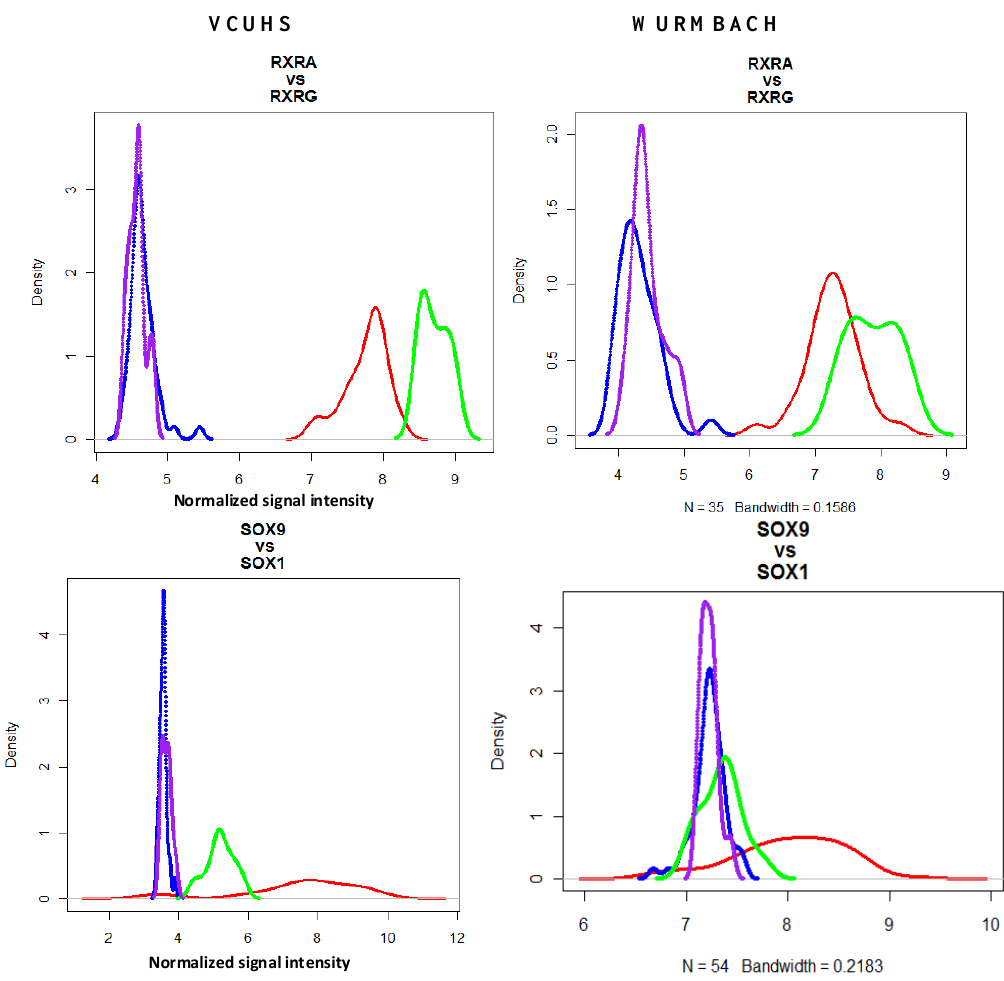
Figure 1. Selected density plots of liver development vs . paralog non-liver development genes. Expression densities are shown for gene pairs in normal and HCC samples from our data and in the Wurmbach dataset. Red = expression of the liver gene in HCC; Green = expression of liver gene in normal controls; Blue = expression of non-liver gene in HCC; Purple = expression of non-liver gene in normal controls. Paralog genes ( RXRG and SOX1 ) were not expressed in HCC or normal samples, while liver development genes RXRA and SOX9 were differentially expressed in HCC. These patterns were also observed in the Wurmbach